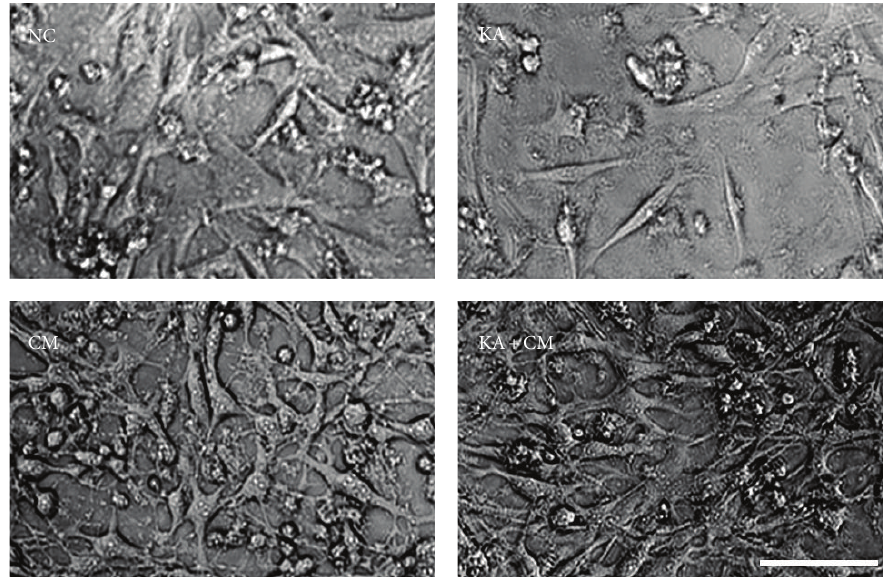
Figure 1: Neuromorphological alteration. Representative photomicrographes demonstrating the morphology of H3 cells in different treatment groups. Kainic acid treatment to H3 cells resulted in prominent decrease in cell density and neurites. In contrast, KA + CM group demonstrated healthy cell bodies with dense neurites. Scale Bar 100 𝜇 m. Normal control (NC), normal control exposed to HEK conditioned medium (CM), Kainic acid alone treated (KA), and Kainic acid and HEK conditioned medium cotreated (KA + CM).